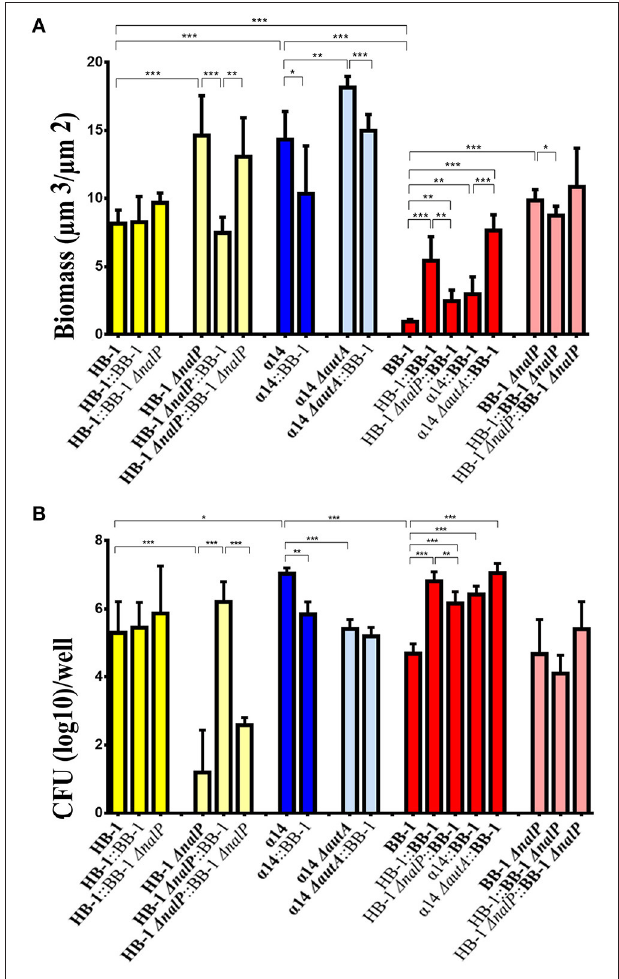
FIGURE 3 | Characteristics of single- and dual-strain biofilms. Biofilms were formed of various combinations of Nm strains HB-1 and BB-1 and their nalP mutant derivatives, and α 14 and its autA mutant derivative and biomass and CFU were determined. The strains present in the consortium are shown at the bottom of each panel. The data shown are for the strain indicated in bold. (A) The biomass of biofilms was calculated for each strain using COMSTAT. The biomass for each strain in the consortium is shown separately. (B) Numbers of CFU. The CFU for each strain in the consortium is shown. To allow for strain discrimination in dual-strain biofilms, strains with different antibiotic-resistance markers were used as indicated in Table S1. The CFU for each strain were determined by plating on GC medium containing kanamycin, rifampicin or gentamicin and overnight incubation. Results are means and standard deviations of three independent experiments. Statistically significant differences are marked with one ( P < 0.05), two ( P < 0.005) or three asterisks ( P < 0.0005) (unpaired t